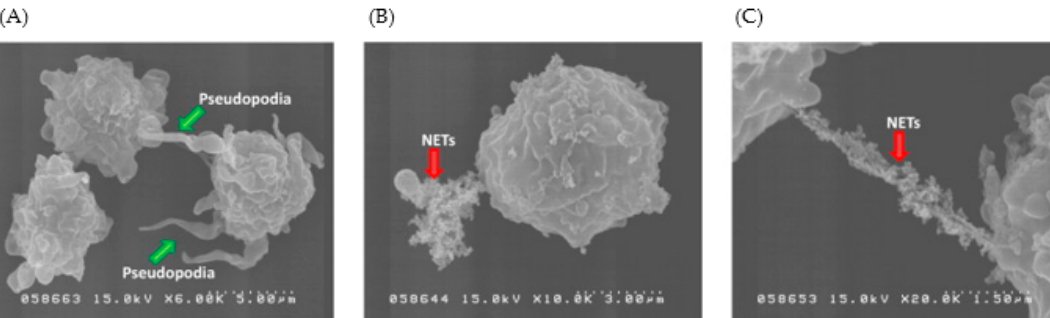
Figure 7. The morphology of human neutrophils examined by SEM after treatment of ( A ) cationic SLNs (55 lg/mL) at a magnification of 6000×; ( B ) cationic SLNs (55 lg/mL) at a magnification of 10,000×; and ( C ) cationic SLNs (55 lg/mL) at a magnification of 20,000×